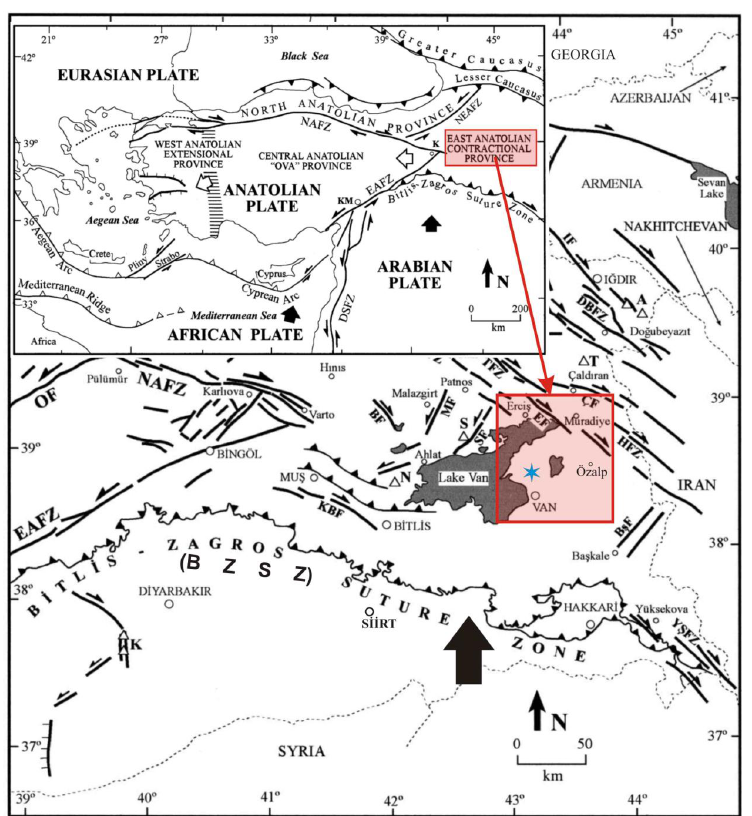
Figure 1. Location map of the study area and simplified active tectonic lines and regions in Turkey. General view of active faults in Van and surrounding areas along with direction of compressional stress creating the compression area in East Anatolia. The 23 October 2011 Van earthquake region is shown in a red squared area with the earthquake epicenter (blue star). A – Mount Ararat, T – Mount Tend¨urek, S